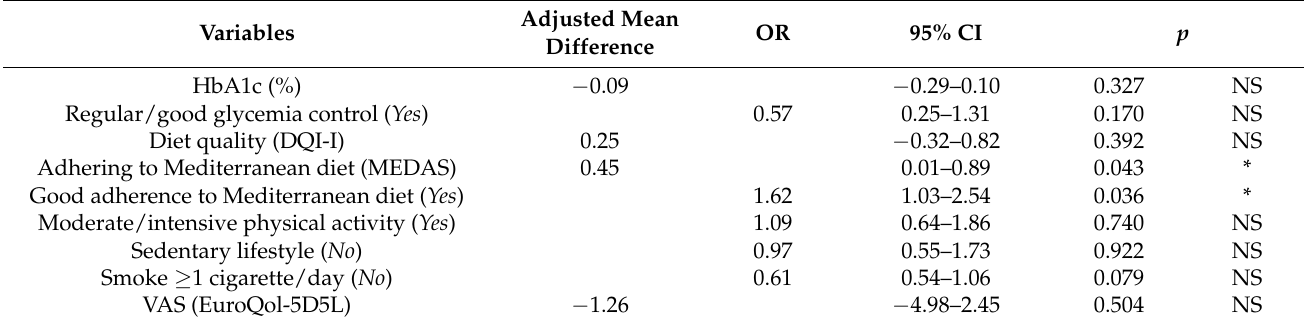
Table 3. Adjusted effectiveness of the intervention in patients with DM. Results by ITT ( n =